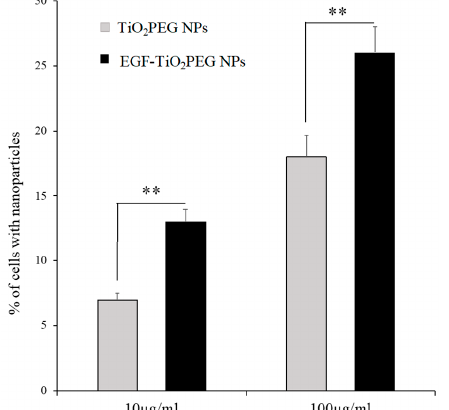
Figure 1. Construction of epidermal growth factor-ligated polyethylene glycol-coated titanium dioxide nanoparticles (EGF-TiO 2 PEG NPs). EGF was mixed with TiO 2 PEG NPs in a 20 mM HEPES bu ff er solution (pH 7.4) at 4 ◦ C overnight. The mixture was centrifuged and reconstituted with free sterilized water. This substitution process was repeated three times, then EGF-conjugated TiO 2 PEG NPs were collected. The conjugation e ffi cacy was more than 90% of the initial amount of EGF.